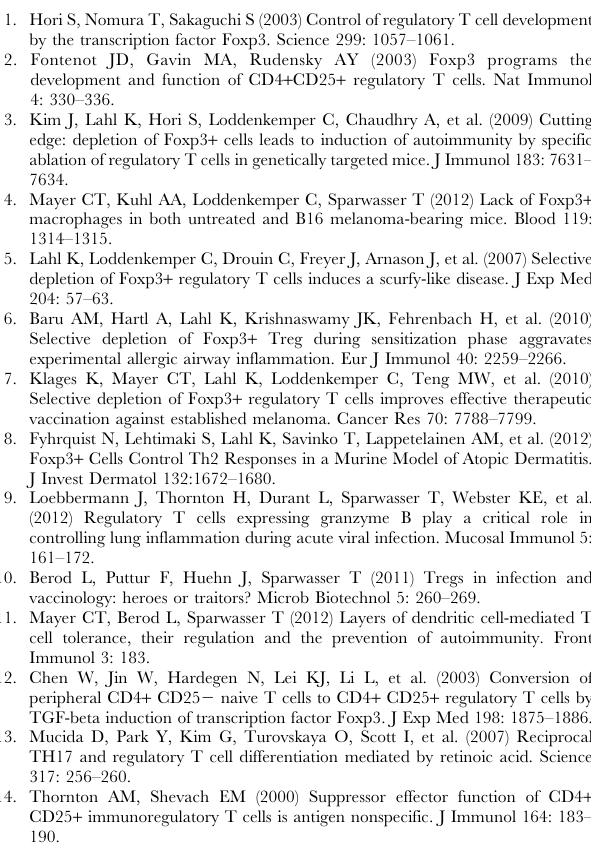
(17A2; eBioscience) for four days. Negative controls lacked anti- CD3e stimulation. On the fourth day of co-culture, proliferation of Tresp cells was evaluated by FACS upon quantification of the cells undergoing proliferation as scored by dilution of CellTrace TM Violet on live CD4 + gated cells. Figure S1 Foxp3 expression in sorted CD4 + eGFP 2 CD25 2 cells used to generate iTregs from DEREG mice. Left panel demonstrates eGFP and Foxp3 expression on live unsorted CD4 + enriched T cell population from DEREG mice, and right panel demonstrates the eGFP and Foxp3 expression on live FACS sorted CD4 + eGFP 2 CD25 2 T cells which were then used for iTreg differentiation. (TIF) Figure S2 Kinetic analysis of eGFP and Foxp3 expres- sion in in vitro differentiated iTregs with GM-CSF derived BMDC and soluble anti-CD3. Frequency of live CD4 + eGFP + Foxp3 + , CD4 + eGFP + Foxp3 2 and CD4 + eGFP 2 - Foxp3 + cells were calculated by FACS each day, from initiation of cultures up to day 5. Data presented here is the mean of triplicates analyzed per day from one representative DEREG mouse out of 7 individual mice. Error bars represent the SD of triplicates. (TIF)